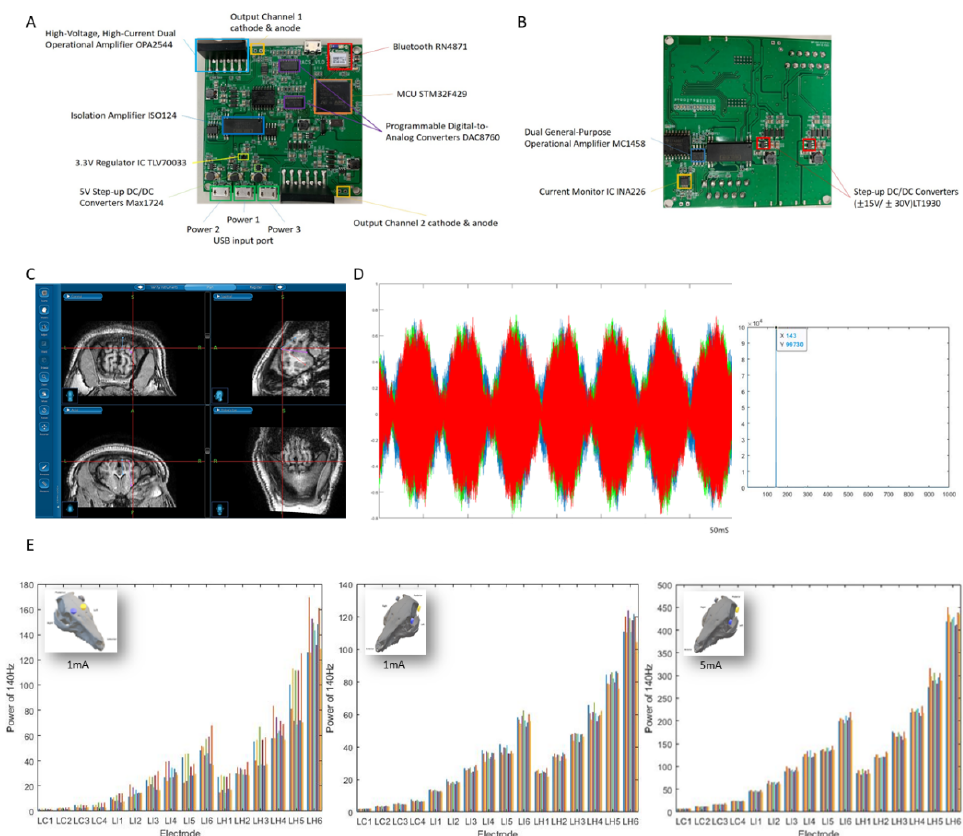
Figure 1. The front view ( A ) and back view ( B ) of the electronic component and circuit board of the novel transcranial electric stimulation device. ( C ) Three trajectories for depth electrodes planned with neuro-navigation, targeting left cingulate gyrus, insula, and hippocampus. ( D ) The envelope created by the tACS on 2 K and 2.14 K Hz. The signal captured from depth electrode at hippocampus shows that the electric field was 0.68 mv/mm, and frequency was 140 Hz. ( E ) The schematic view of the electrodes deployment and the power of 140 Hz signal. The power increased when the electrodes were shifted closer to hippocampus or when the current elevated. LC, left cingulate gyrus; LI, left insula; LH, left hippocampus.